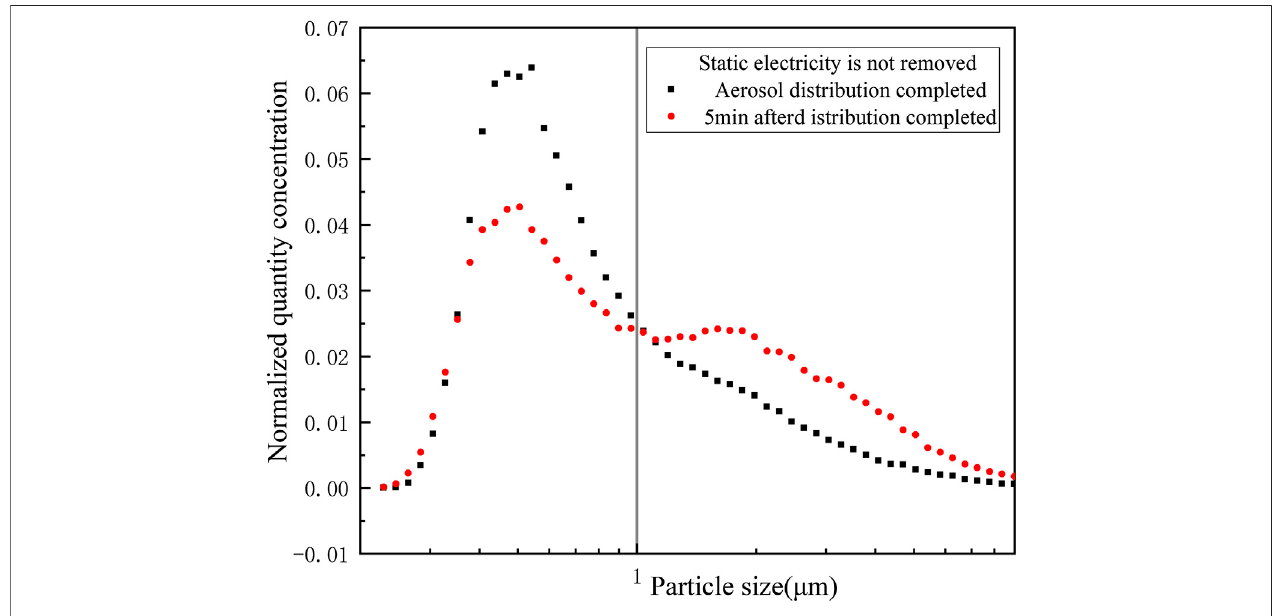
FIGURE 4 | Electrostatic effect on erosol distribution. Presence of electrostatic.